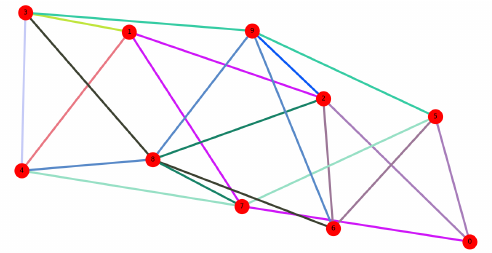
Figure 1. Example of network model for n 1 =